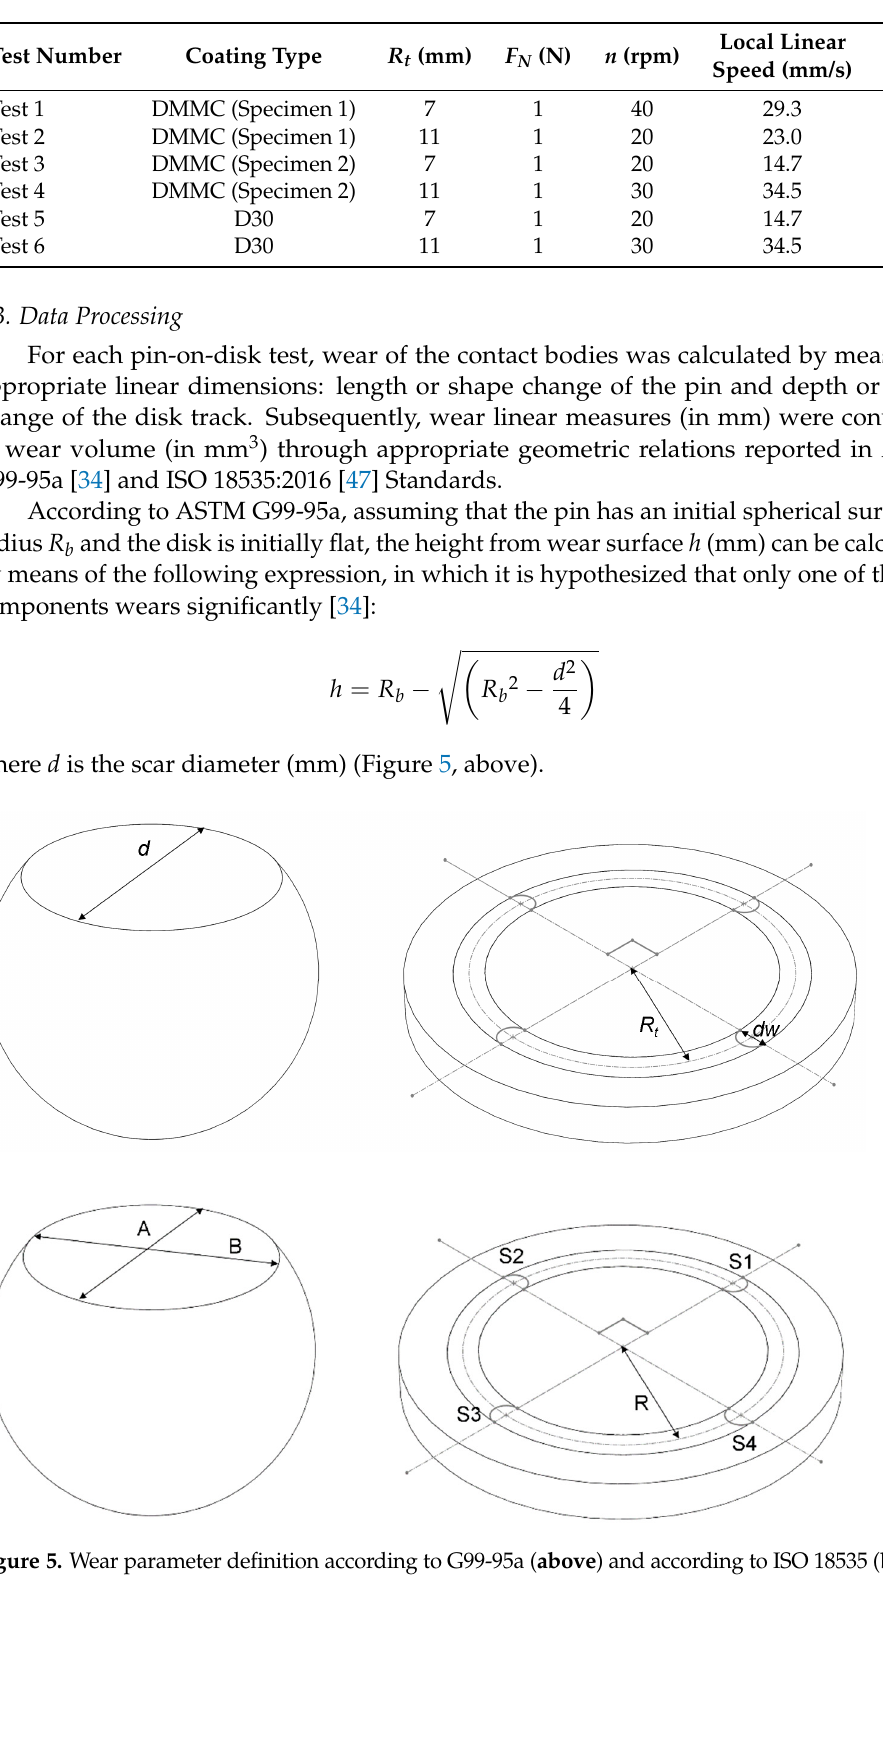
Table 4. Test conditions.